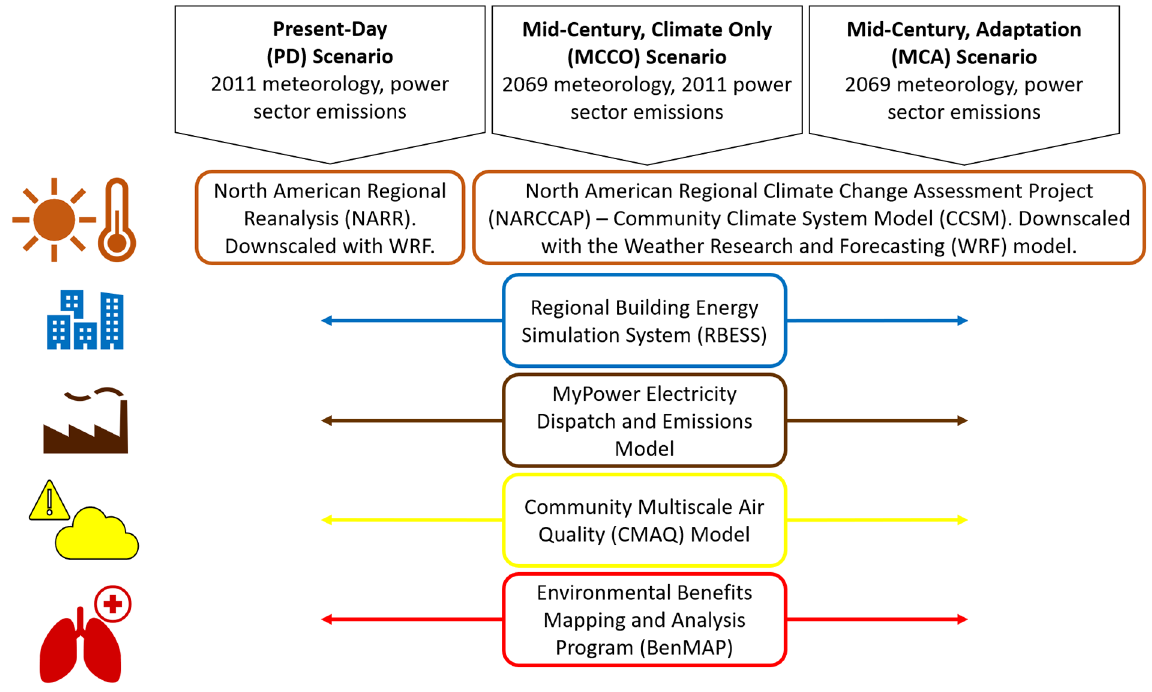
Fig 1. A visual representation of the methods used in this